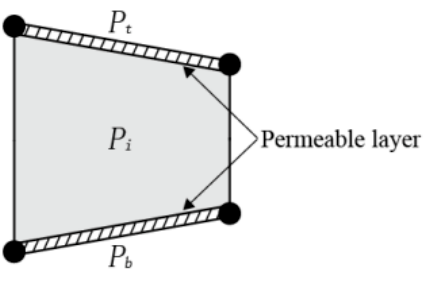
Figure 3. Filtration of fracturing fluid in a permeable layer.